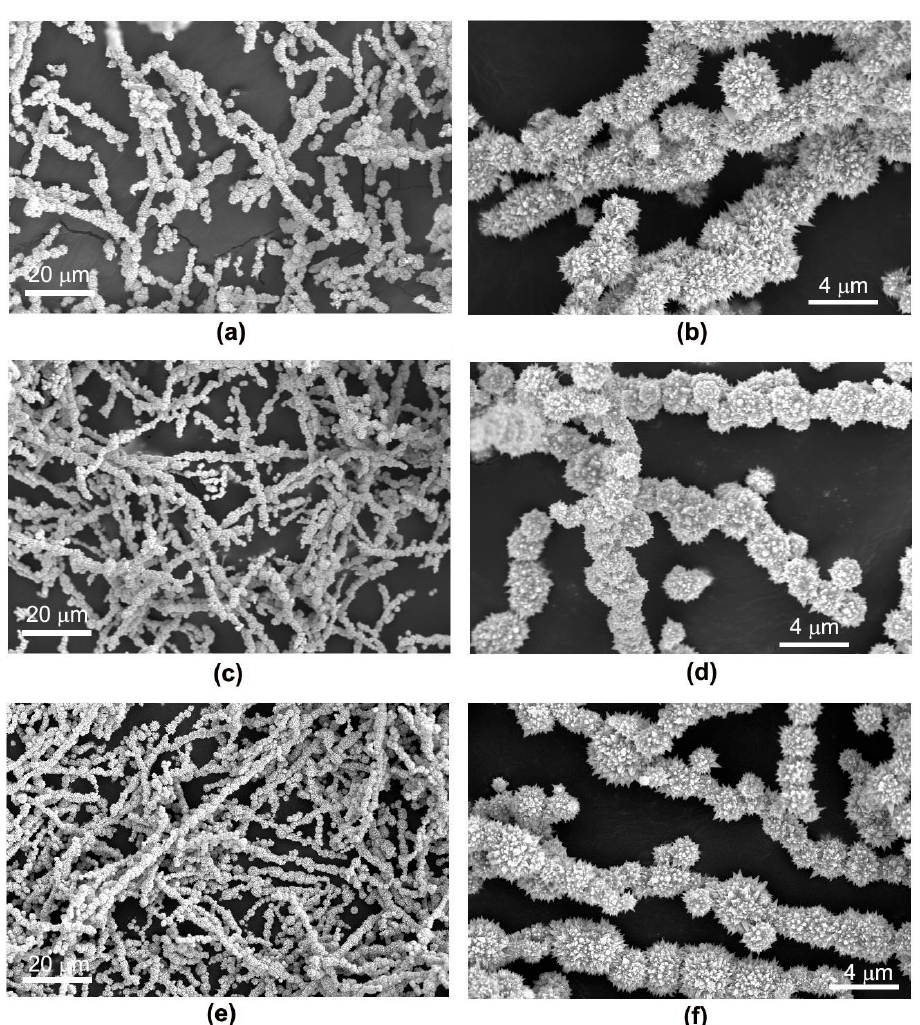
Figure 7. SEM images of the products formed in the presence of 3 mL of EDA in a 15 M NaOH solution of different amounts: ( a , b ) 100 mL, ( c , d ) 50 mL, and ( e , f ) 25 mL. Reaction duration is 6 h.